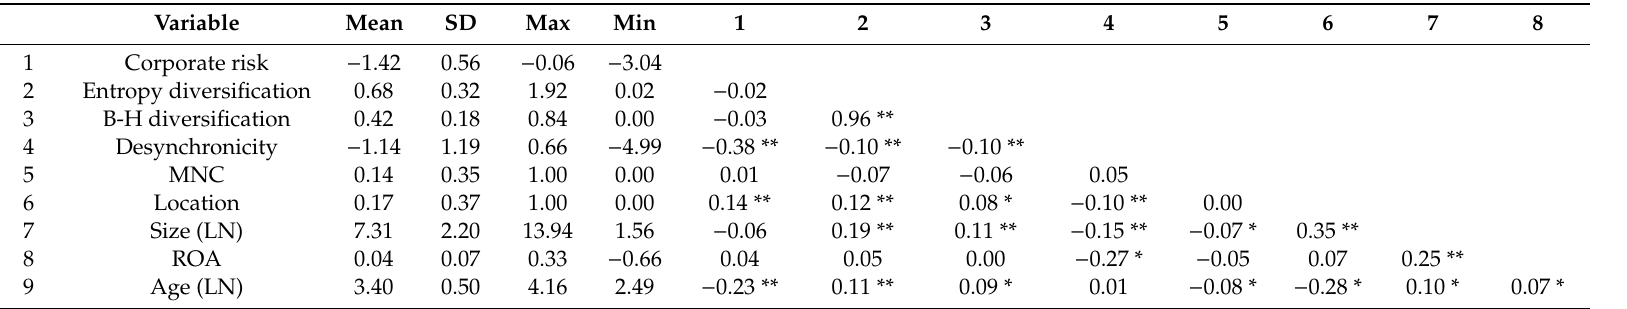
Table 1. Summary of Key Statistics and Correlations of Variables—relating sales to